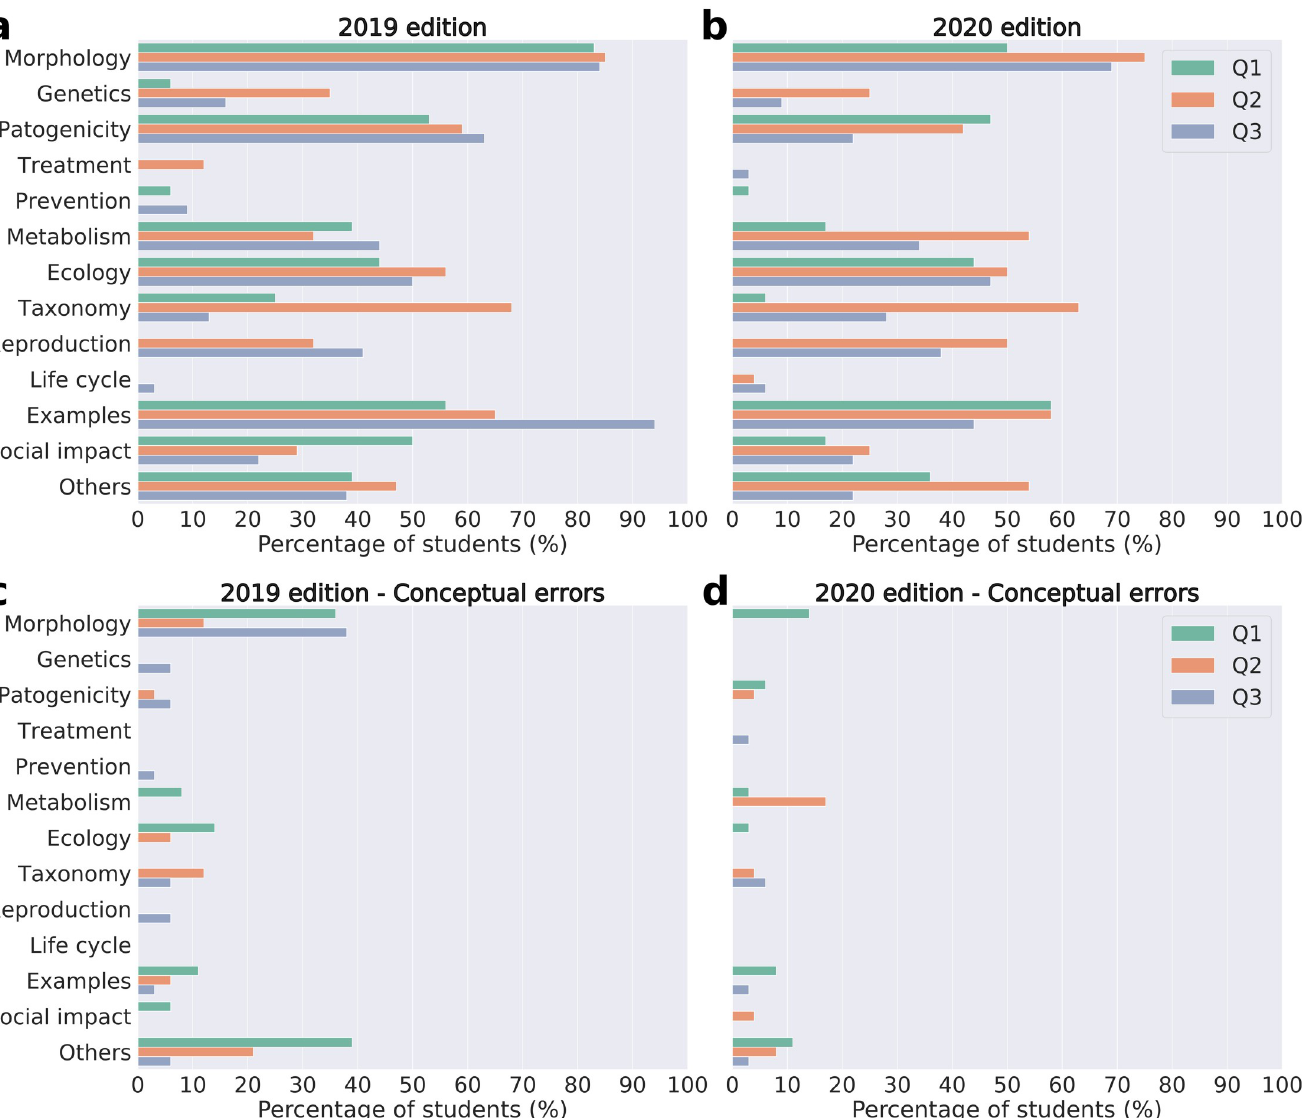
Fig 1. Percentage of students that commented on each topic. Percentage of students that commented on the topic at least once in the: Q1 survey, applied before the start of “Adopt a Microorganism”; Q2 survey, applied after the hands-on practical activities in 2019 and immediately after the end of the Facebook 1 discussions in 2020; Q3 survey, applied five months after the end of the project. [a] microbiology topics that were cited correctly in 2019; [b] microbiology topics that were cited correctly in 2020; [c] microbiology topics that were wrongly cited (conceptual errors) in 2019; [d] microbiology topics that were wrongly cited (conceptual errors)